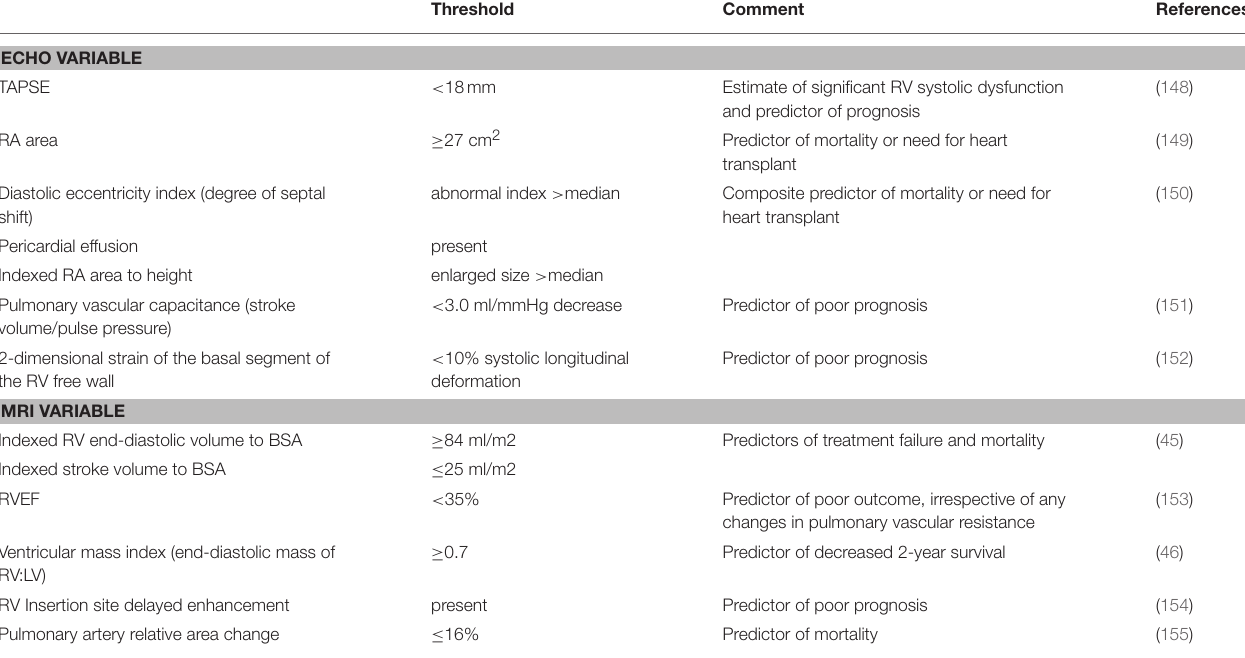
TABLE 2 | Prognostic parameters in pulmonary